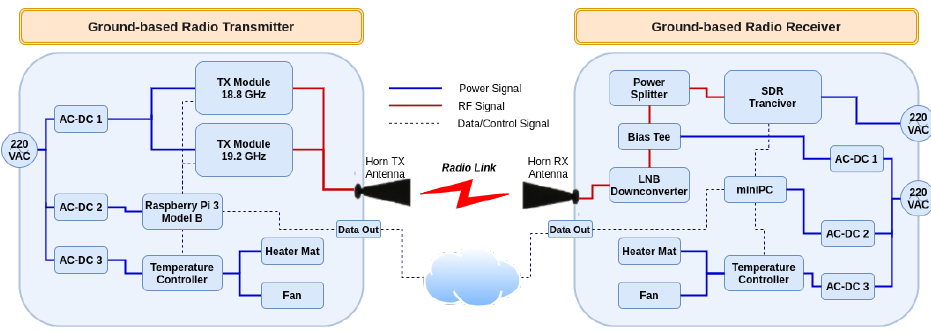
Figure 2. SWAMM-2.0 system